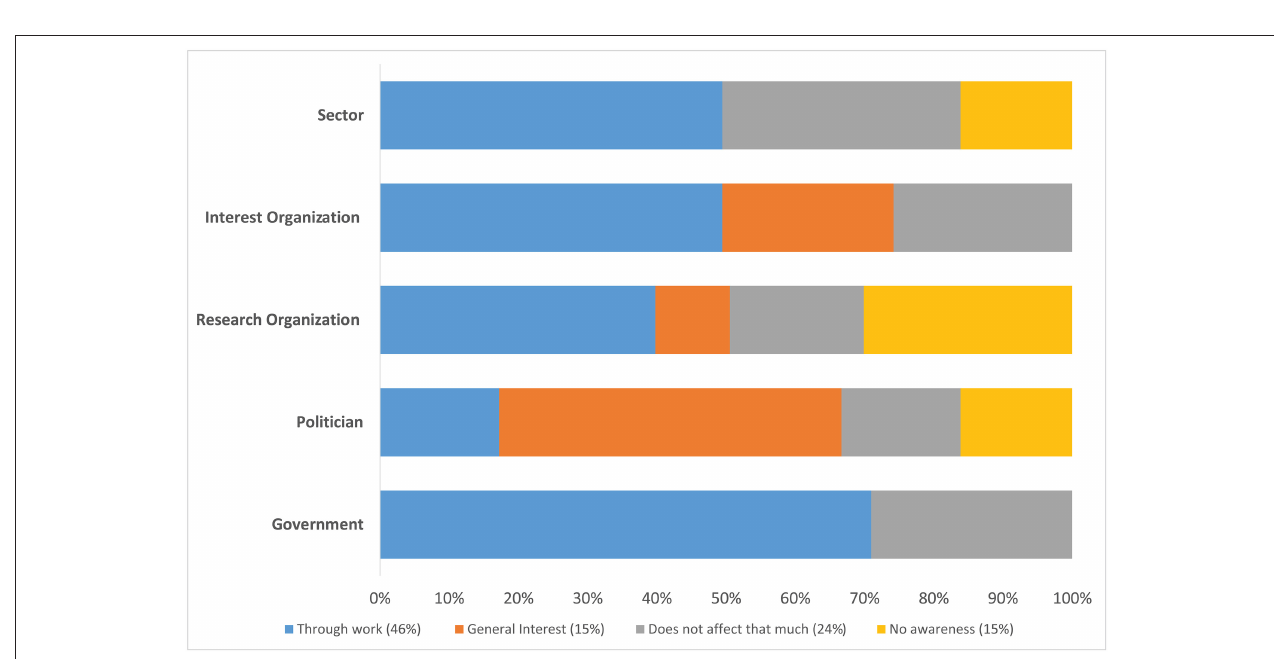
FIGURE 2 | Stakeholder descriptions of how the microplastics issue affects them. Percentages reported represent the frequency with which an issue was mentioned across all stakeholders responding ( n = 33).